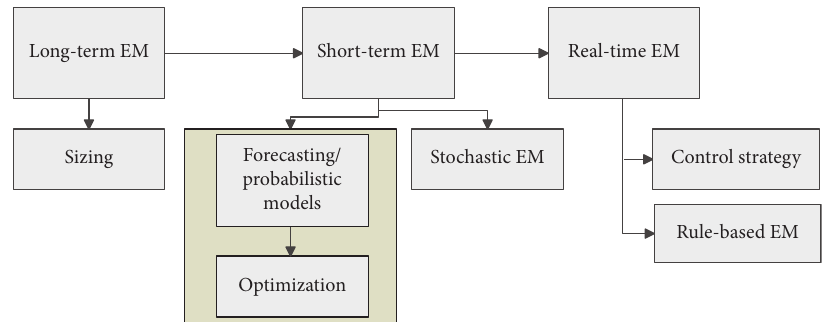
Figure 8: The proposed EM